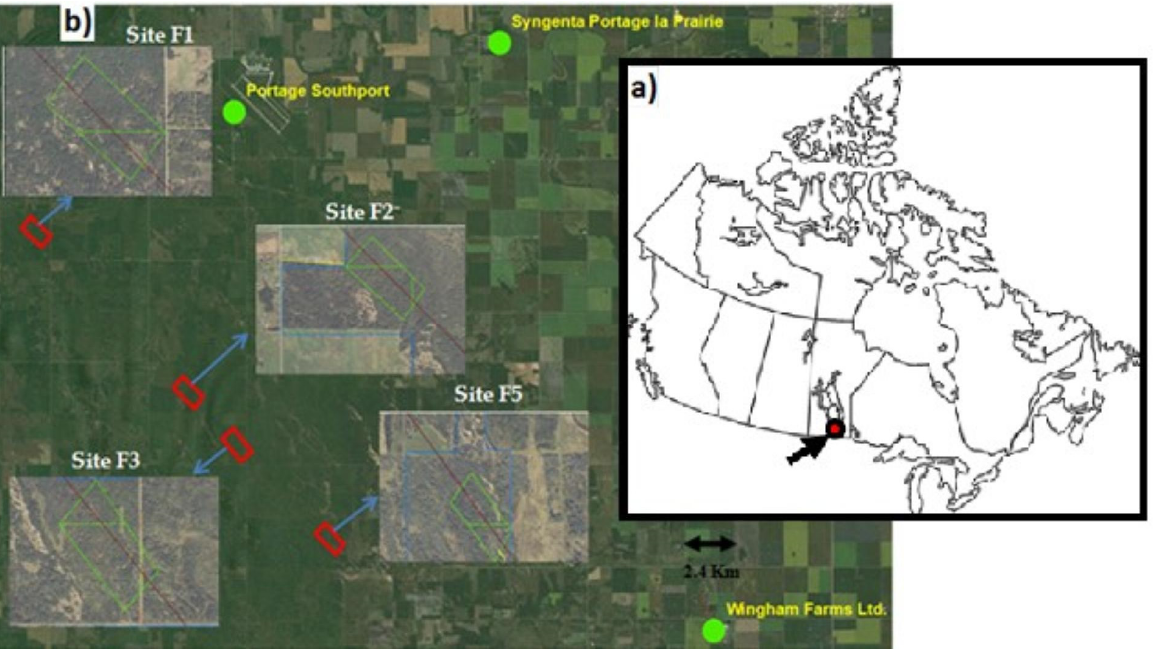
Figure 1. Location of ( a ) SMAPVEX12 area and ( b ) four forested sampling sites of